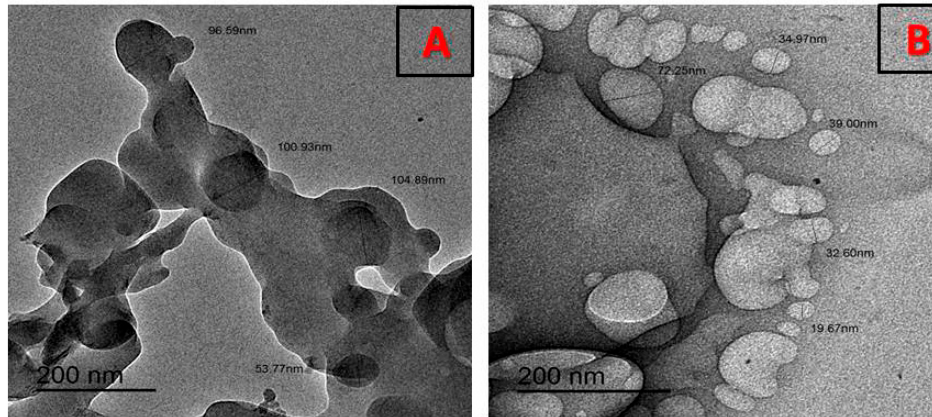
Figure 8. TEM of ( A ) PRD and ( B ) PRD/Zn.